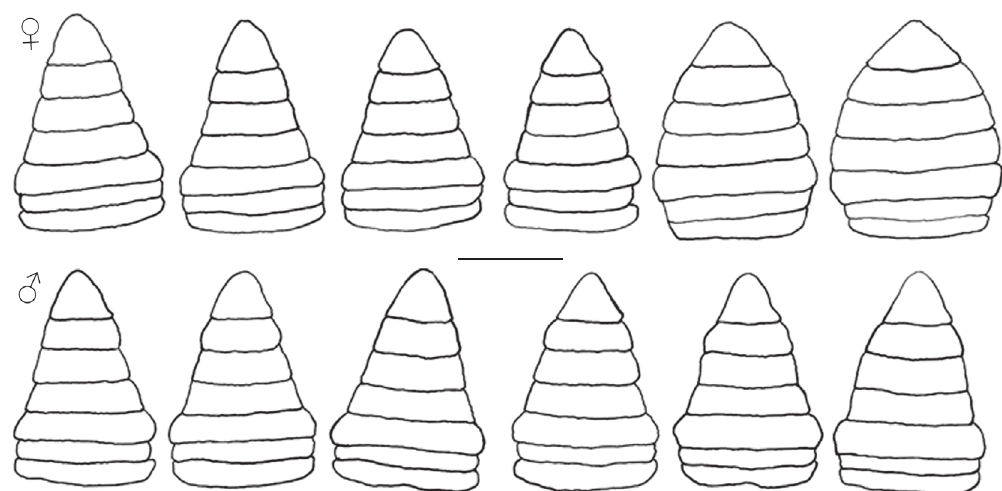
Figures 34. Pachygrapsus gracilis , male and female abdomen from juvenile instar II to VII. Scale bar: Females – JII = 0.8 mm; JIII = 1.0 mm;: JIV = 1.2 mm; JV = 1.5 mm; JVI = 2.2 mm; JVII = 2.0 mm. Males – JII = 0.8 mm;: JIII = 1.0 mm;: JIV = 1.1 mm; JV = 1.4 mm; JVI = 2.1 mm; JVII = 2.2